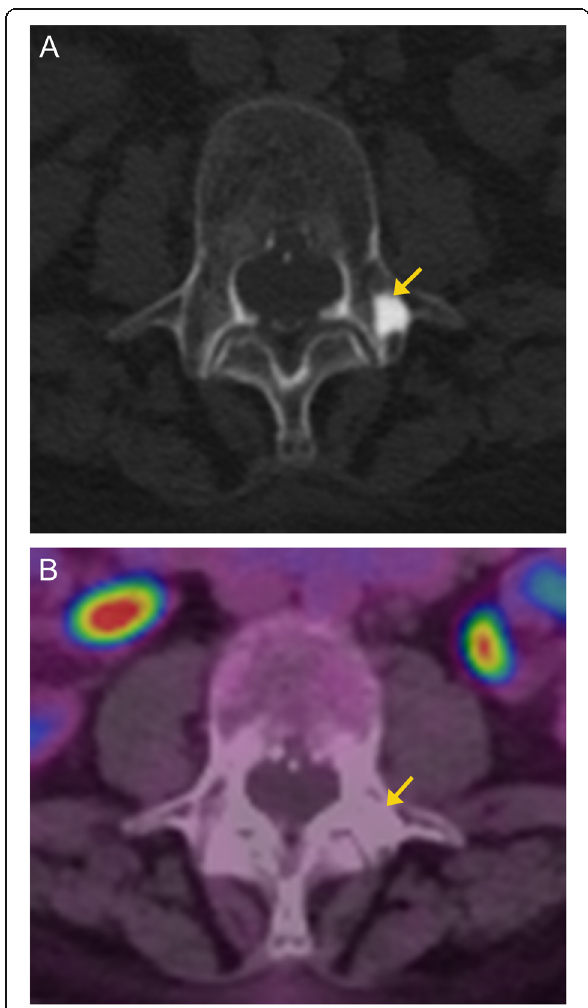
Fig. 4 Enostosis. Axial CT image ( a ) of the thoracic spine demonstrates a focal sclerotic bone lesion with characteristic dense sclerosis and irregular and brush-like margins (arrow). No associated soft tissue component. Axial fused PET/CT image ( b ) demonstrates lack of metabolic activity of the bone lesion (arrow), confirming the